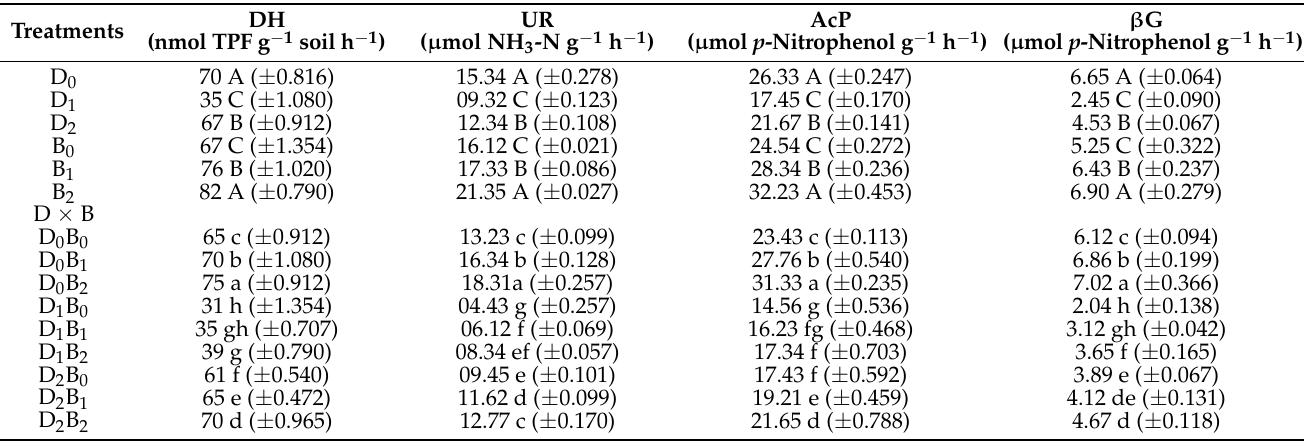
Table 6. Effect of Biochar on Soil dehydrogenase (DH), urease (UR), acid phosphatase (AcP), and β -glucosidase ( β G) activities in the soil of wheat crop under water-limited stress condition.